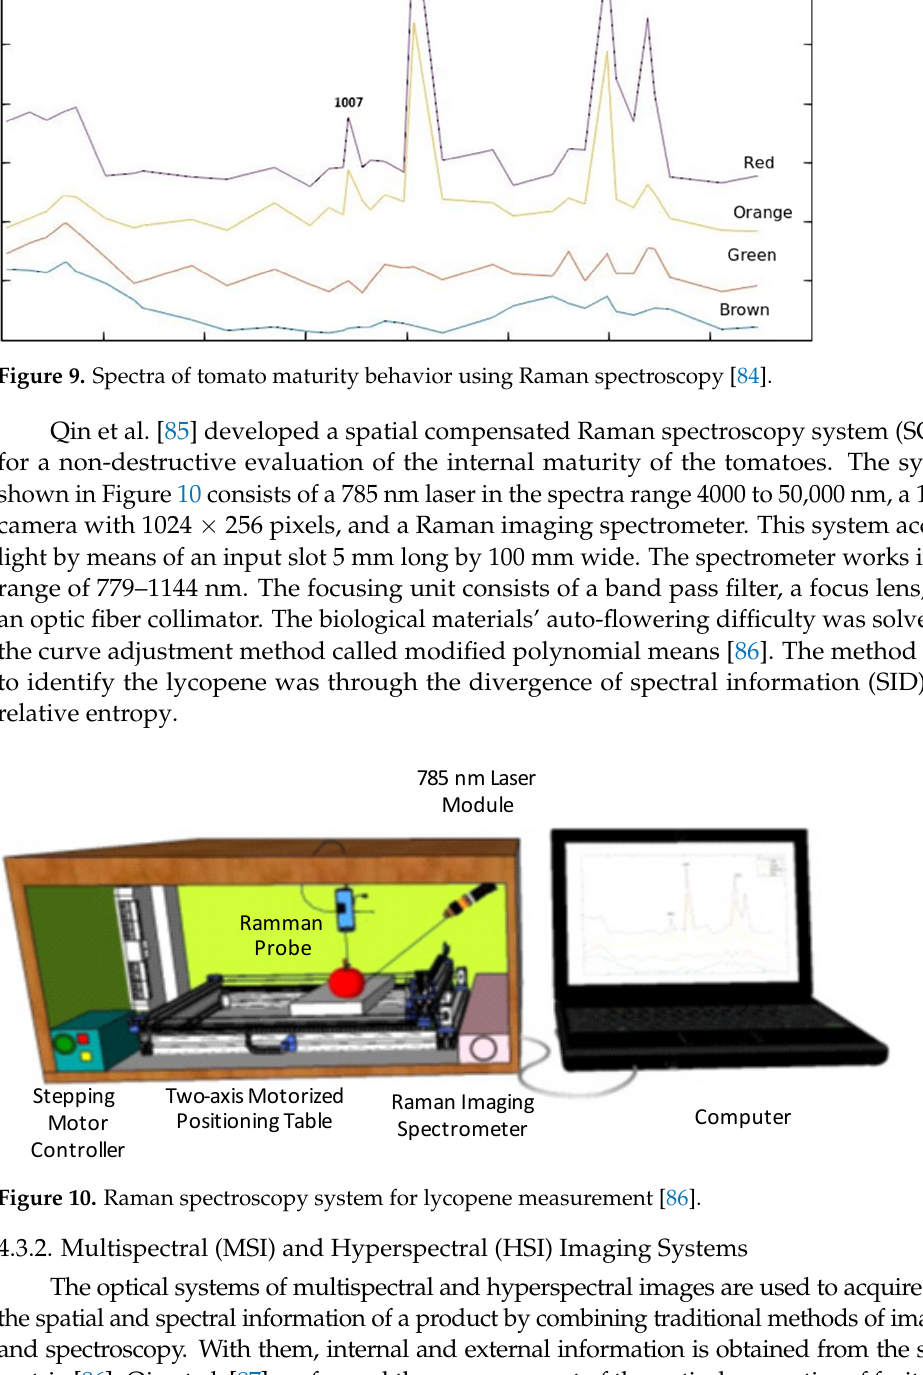
Figure 10. Raman spectroscopy system for lycopene measurement [86].